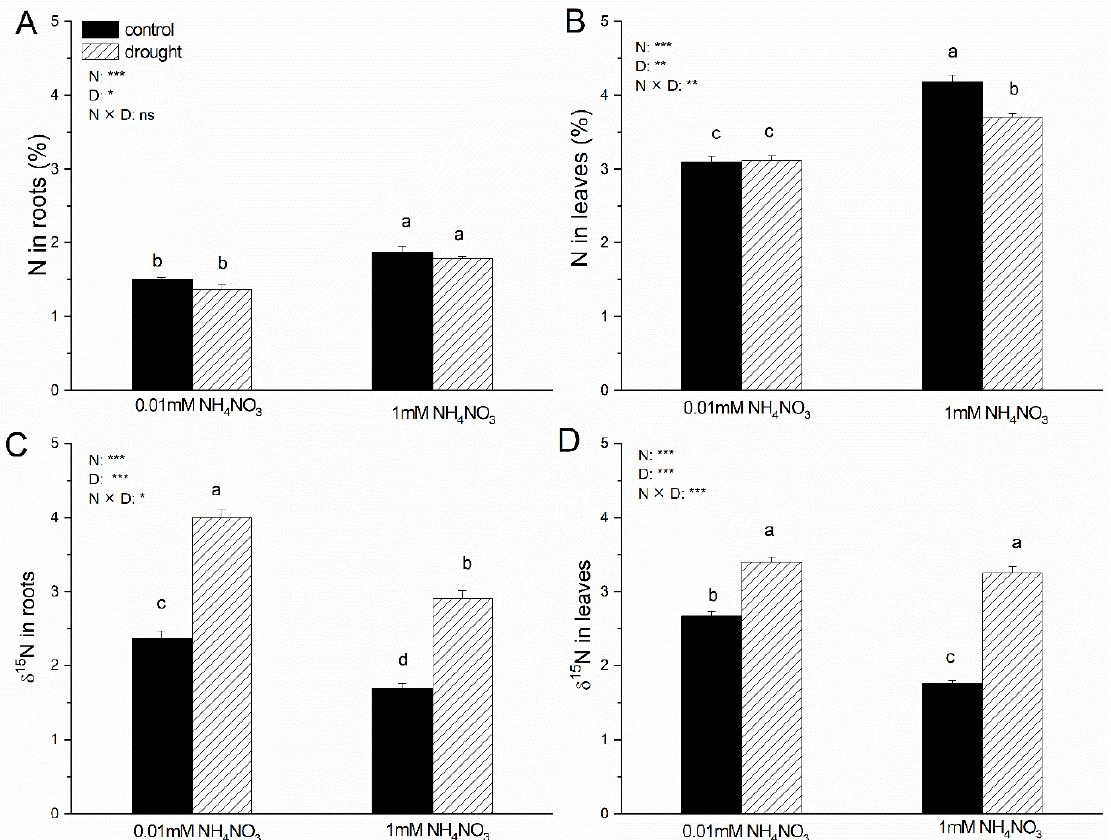
Figure 4. Total N concentration and δ 15 N in roots ( A , C ) and leaves ( B , D ) of Populus simonii as affected by nitrogen supply and drought stress. Data indicate mean ± SE ( n = 6). Different letters in the same column indicate significant differences. N, N supply; D, drought treatment; N × D, interaction of N supply and drought treatment. *, p < 0.05; **, p < 0.01; ***, p < 0.001; ns, not significant.